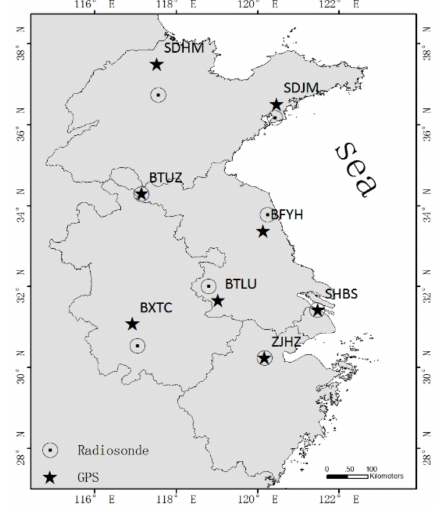
Figure 1. Distribution map of the experimental